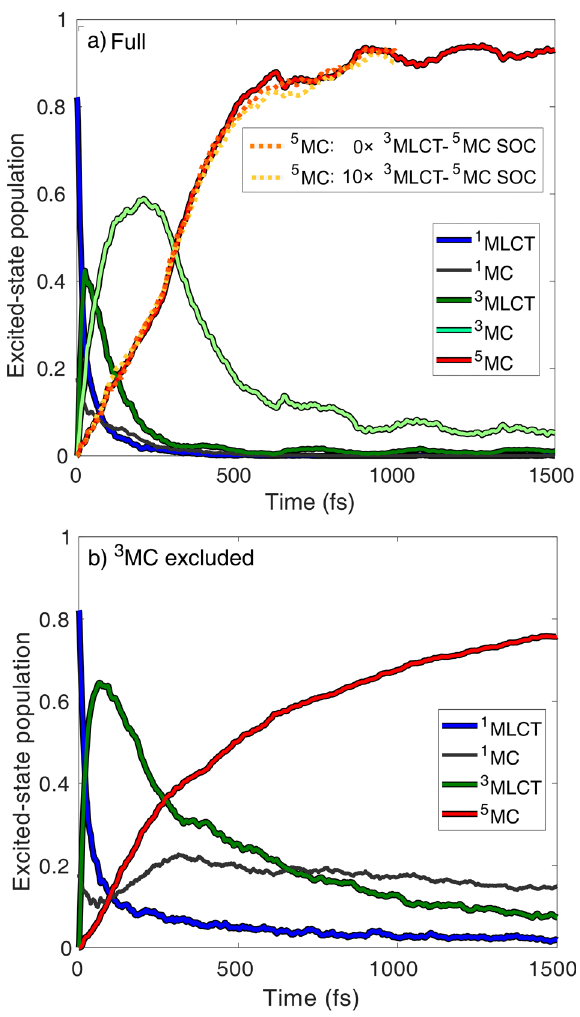
Fig. 2 Simulated excited-state population dynamics of [Fe(terpy) 2 ] 2 + . a Full simulation, the orange, and yellow dotted quintet population curves were obtained by decreasing the 3 MLCT- 5 MC SOCs to zero and enlarging them by 10×, respectively, while retaining all other parameters. b 3 MC states excluded. The overall excited-state population is normalised to unity. The contribution of the ground-state population is small throughout the simulated dynamics (~10% and 0% at 1.5 ps for a and b , respectively), see Supplementary Figure 1.